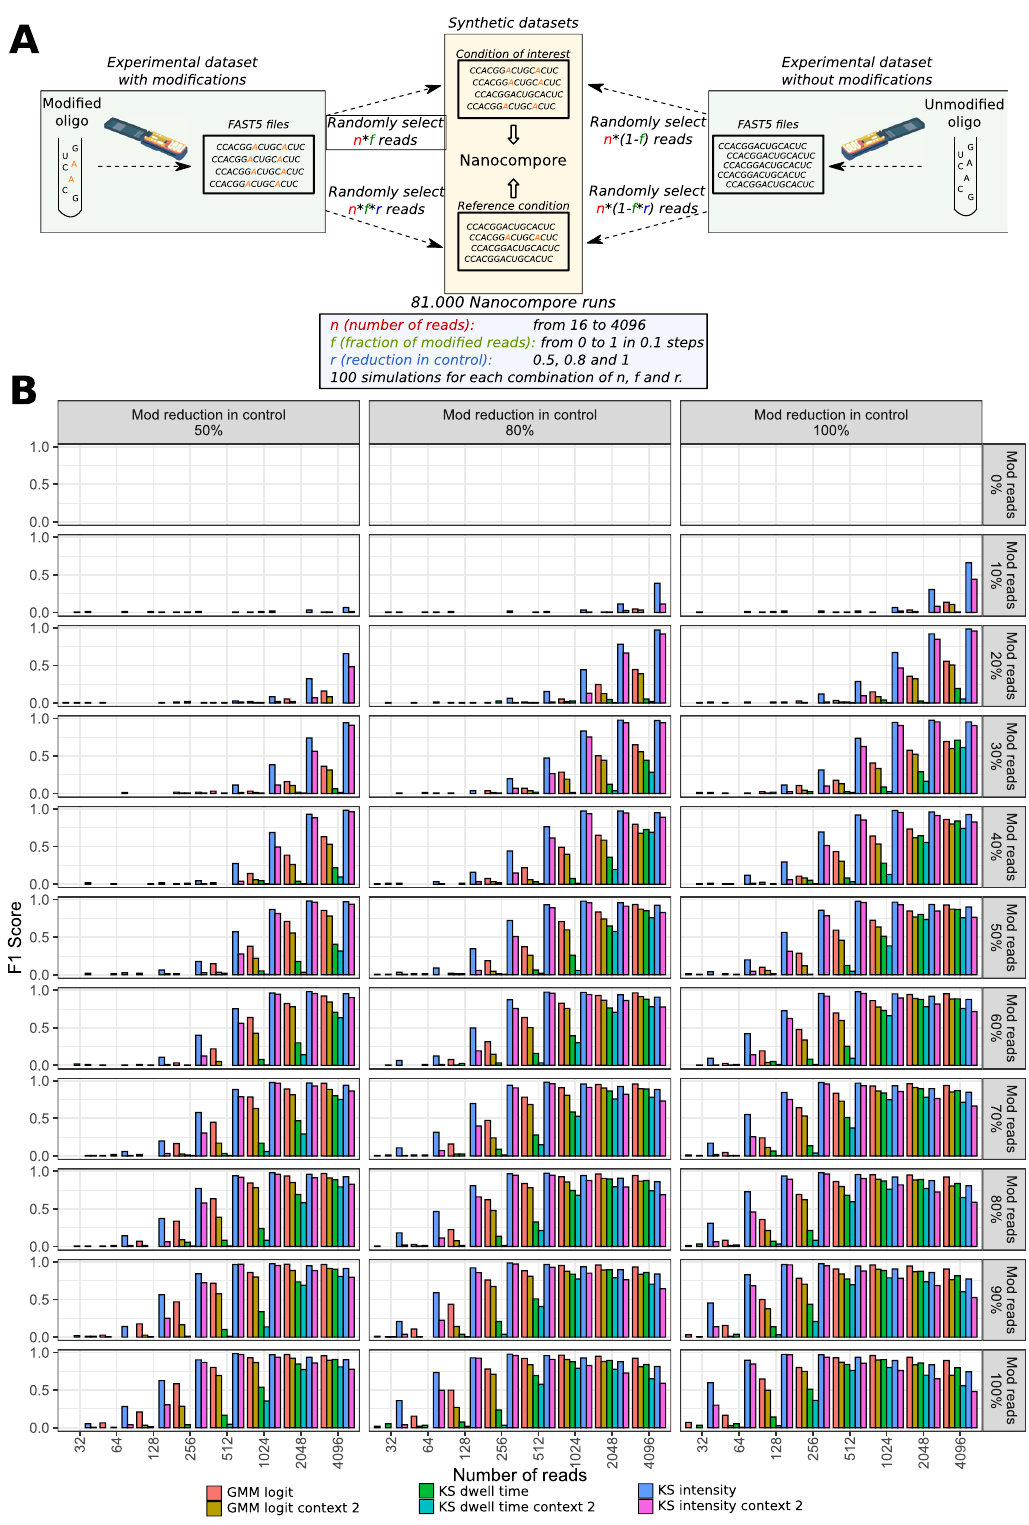
Fig. 3 Nanocompore benchmarks with simulated modi fi cation stoichiometry and knock down ef fi ciency. A Diagram illustrating the procedure used to generate in silico datasets at varying levels of coverage, modi fi cation stoichiometry and knock down ef fi ciency. B Plots showing the F1 score for m6A detection (Oligo1) with the various tests implemented in Nanocompore at varying levels of (1) coverage (x-axis), (2) modi fi cation reduction in control (columns), and (3) percentage of modi fi ed reads (rows). Nominal p -value threshold of